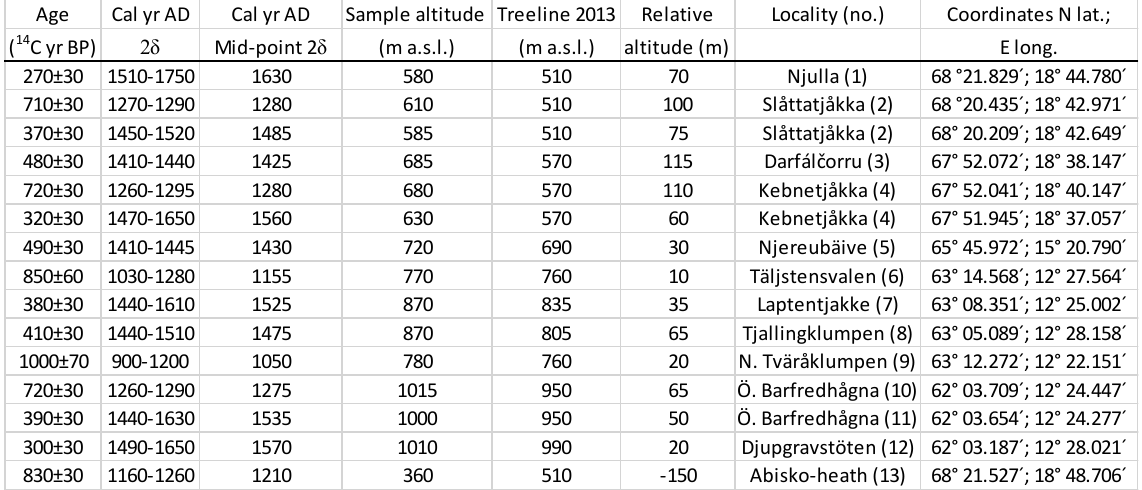
Table 1: Radiocarbon dates of megafossil pine tree remains and their altitudes relative to the present-day (2013) treeline at the respective locality. Age Cal yr AD Cal yr AD Sample altitude Treeline 2013 Relative Locality (no.) Coordinates N